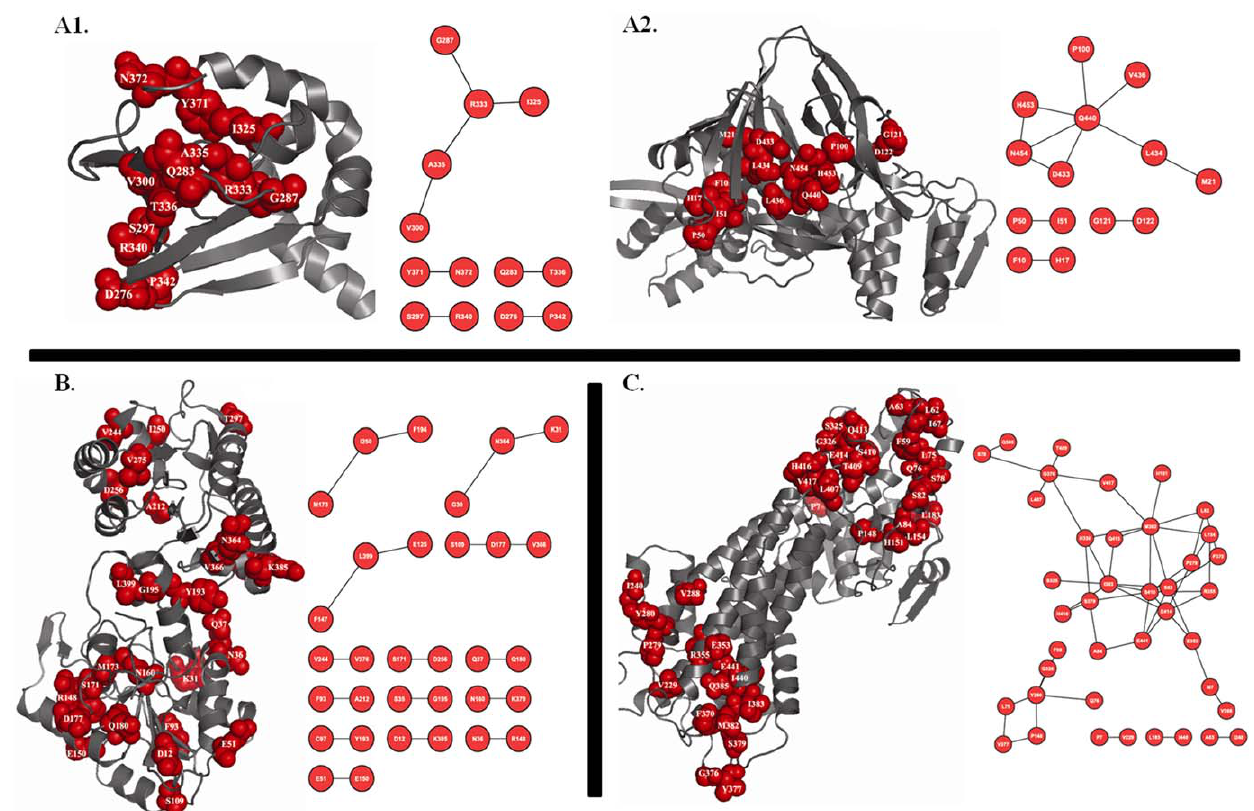
Figure 6. Examples of coevolved sites. Panel A shows two examples where coevolved sites of CAP family of transcription factors (CDD code: cd00038; PDB code: 1RGS) and hedgehog/intein domains (CDD code: cd00081; PDB code: 1DQ3) are projected on their representative protein structures. Panel B shows an example of phosphoglycerate kinase family (CDD code: cd00318; PDB code: 1QPG) while panel C shows an example of coevolutionary connections from phenylalanine ammonia-lyase (PAL) and histidine ammonia-lyase (HAL) domain family (CDD code: cd00332; PDB code: 1GK2). Network representations were created using PyMol [47] and Cytoscape [48] program.